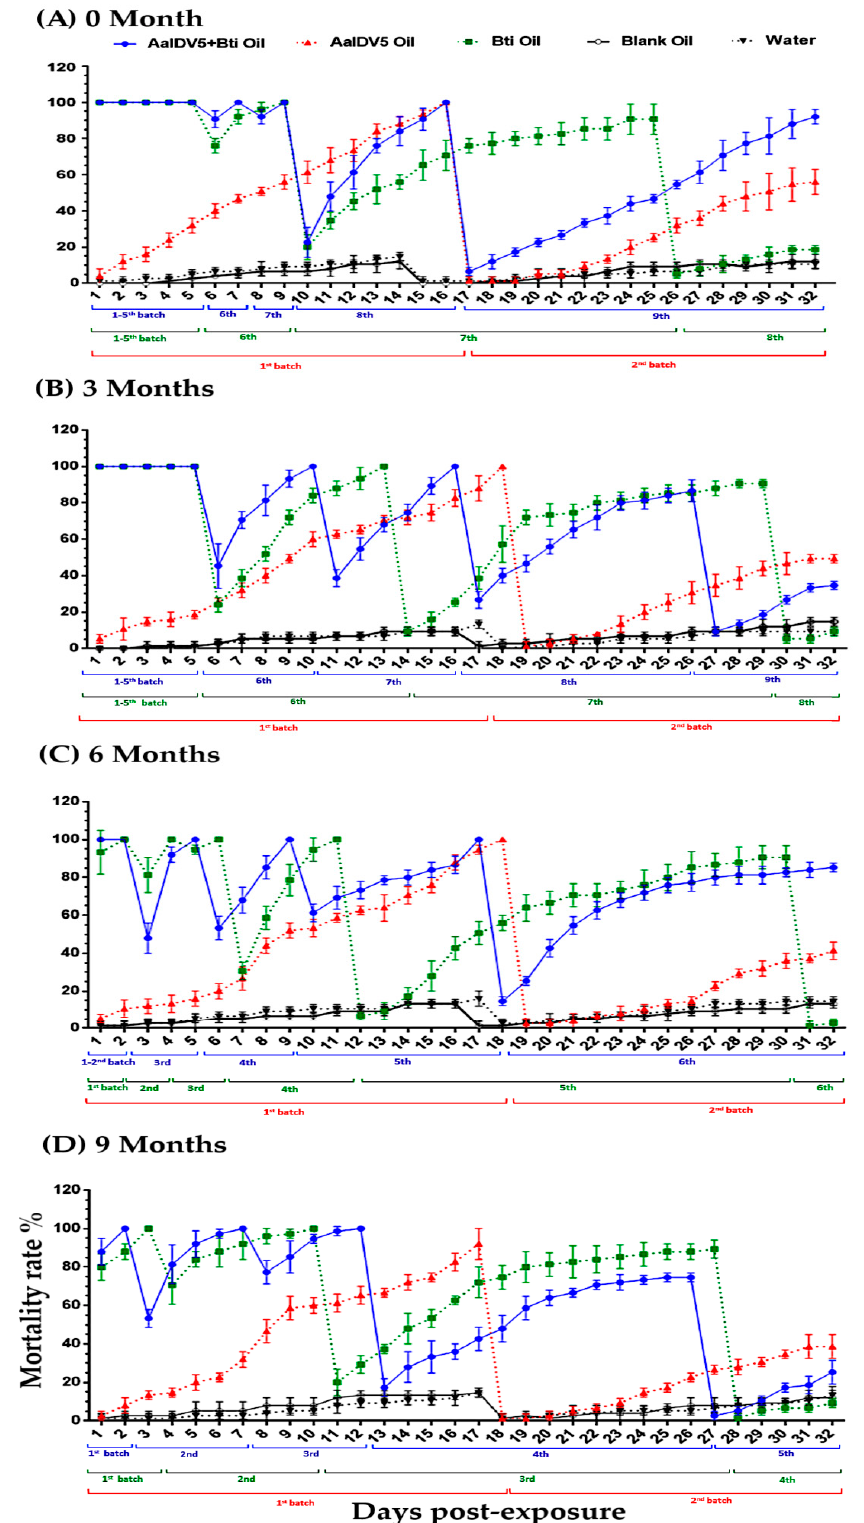
Figure 2. Comparative bioassay of oil suspensions over different storage times (0–9 months) against Ae. albopictus larvae in the semi-field condition. ( A ) Efficacy of oil suspensions on first instar larvae at 0 months, ( B ) 3 months, ( C ) 6 months, and ( D ) 9 months of storage. The bars indicate SDs from three independent (biological)